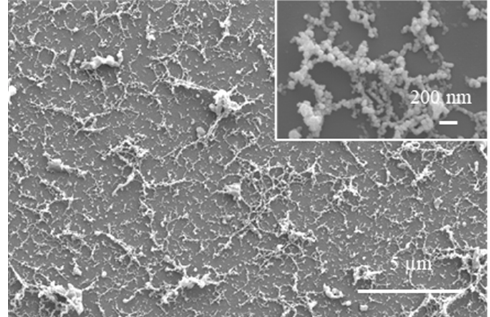
Figure 11. Overall and enlarged (inset) SEM images of CYTOP NPs deposited by single-dot fs laser